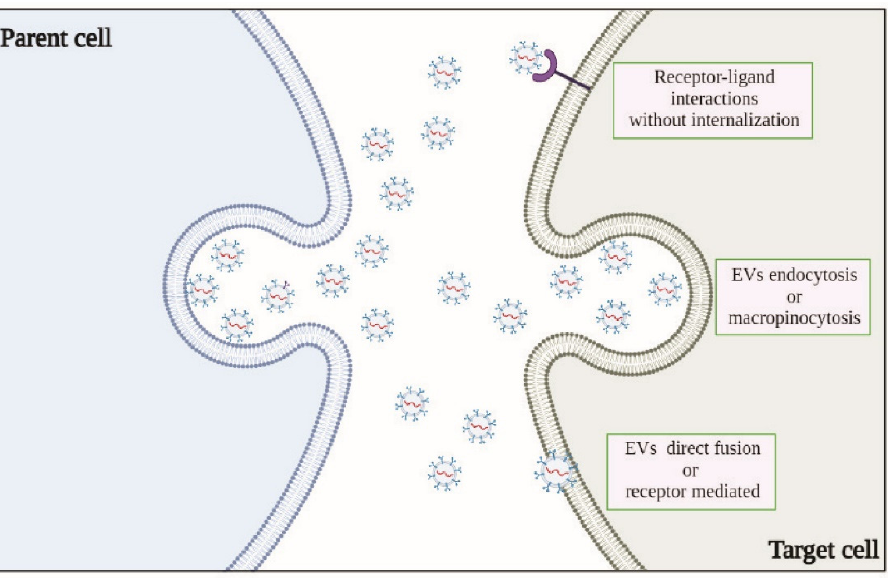
Figure 1. Postulated mechanisms of exosome cell–cell communication.